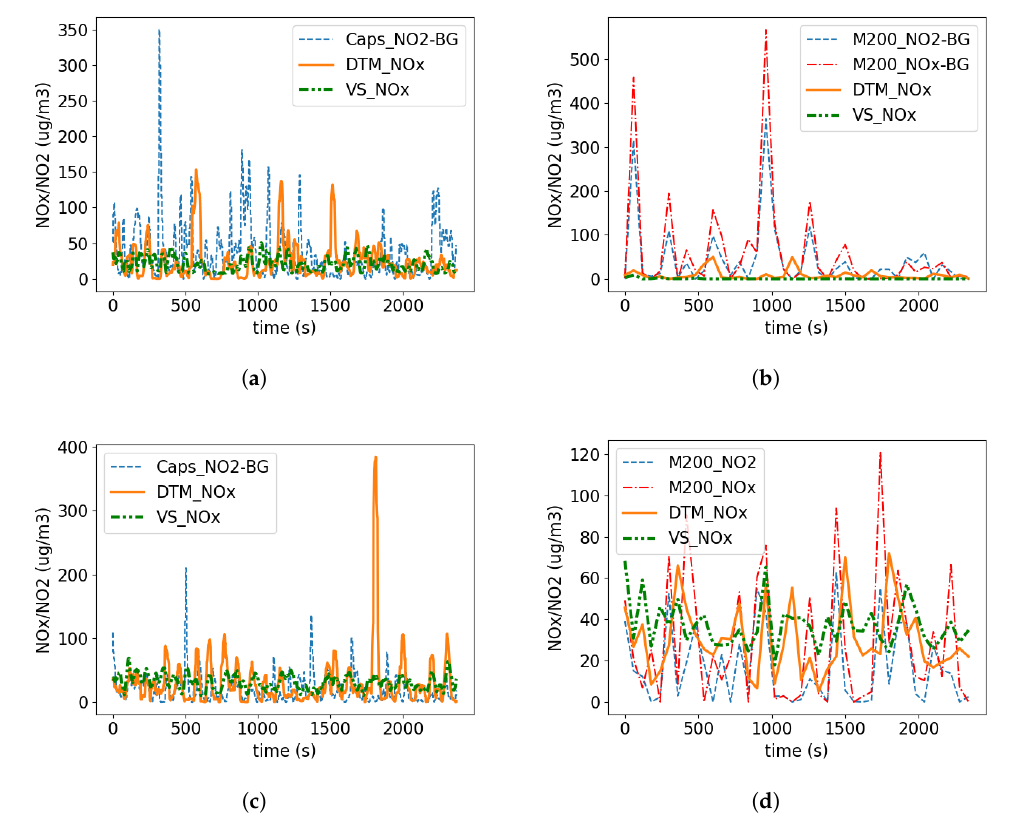
Figure 9. Comparison of measured and modelled timeseries concentrations. ( a ) Day 1 CAPS (30 s rolling average), ( b ) Day 1 M200e (60 s average), ( c ) Day 2 CAPS (30 s rolling average), ( d ) Day 2 M200e (60 s average). The LES concentrations have been time averaged to match the time resolution of each